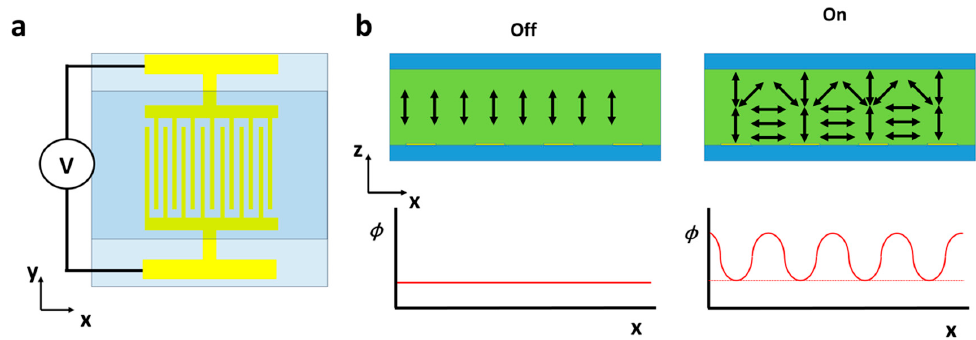
Figure 11. ( a , b ) Diagram of a similar device used by Lindquist et al. in 1994 [138]. Here, a voltage is applied to interdigitated electrodes which create a periodic distortion in the NLC. This is passed onto the transmitted light as an optical phase delay ( ϕ ) of the same period, causing switchable diffraction.